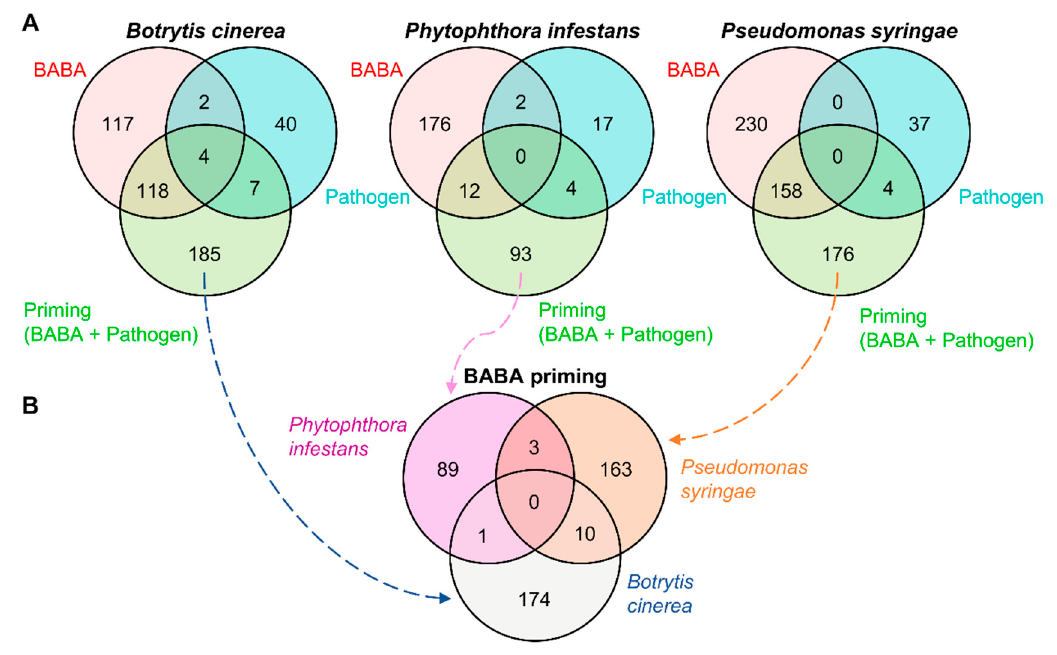
Figure 5. The primed responses are tailored to the encountered pathogenic microbes. ( A ) Venn diagrams showing quantitative binary comparisons were performed for each pathosystem ( t -test, n = 4, P < 0.01) between water-treated, mock-inoculated fruit versus BABA-treated, mock-inoculated fruit (BABA, red); water-treated, pathogen-inoculated fruit (pathogen, blue); BABA-treated, pathogen-inoculated fruit (priming, green). ( B ) Venn diagrams showing the resulting priming clusters for each fruit pathosystem.